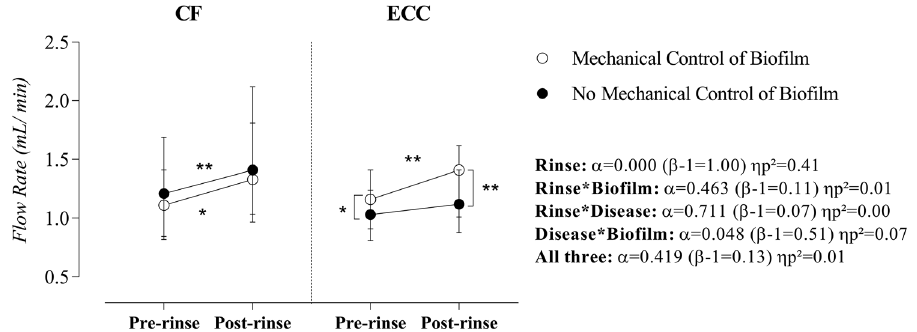
Figure 1. Effect of rinse, mechanical control of biofilm, and disease on salivary flow rate. Statistical analyses were performed with a sample of 56 volunteers, 28 per group. ηp 2 : Partial eta squared. Data plotted as median and interquartile range (due to non-Gaussian distribution). To fulfill the ANOVA premises, we used the log10 transformation. Considering the presence of significant interactions, the main effects of the disease and biofilm were suppressed. A single asterisk represents a significant p-value ≤ 0.05. A double asterisk represents a p-value ≤ 0.01. Simple effects for Rinse in CF children—Mechanical control of biofilm: α = 0.01 (β-1 = 0.75) ηp 2 = 0.12 and No mechanical control of biofilm: α = 0.003 (β-1 = 0.86) ηp 2 = 0.15). Simple effects for Rinse in children with ECC—Mechanical control of biofilm: α = 0.002 (β-1 = 0.88) ηp 2 = 0.16 and No mechanical control of biofilm: α = 0.08 (β-1 = 0.42) ηp 2 = 0.06). Simple effects for Biofilm in CF children—Pre-rinse: α = 0.72 (β-1 = 0.07) ηp 2 = 0.002 and Post-rinse: α = 0.78 (β-1 = 0.06) ηp 2 = 0.002. Simple effects for Biofilm in children with ECC—Pre-rinse: α = 0.02 (β-1 = 0.69) ηp 2 = 0.103 and Post-rinse: α = 0.002 (β-1 = 0.88) ηp 2 = 0.16.